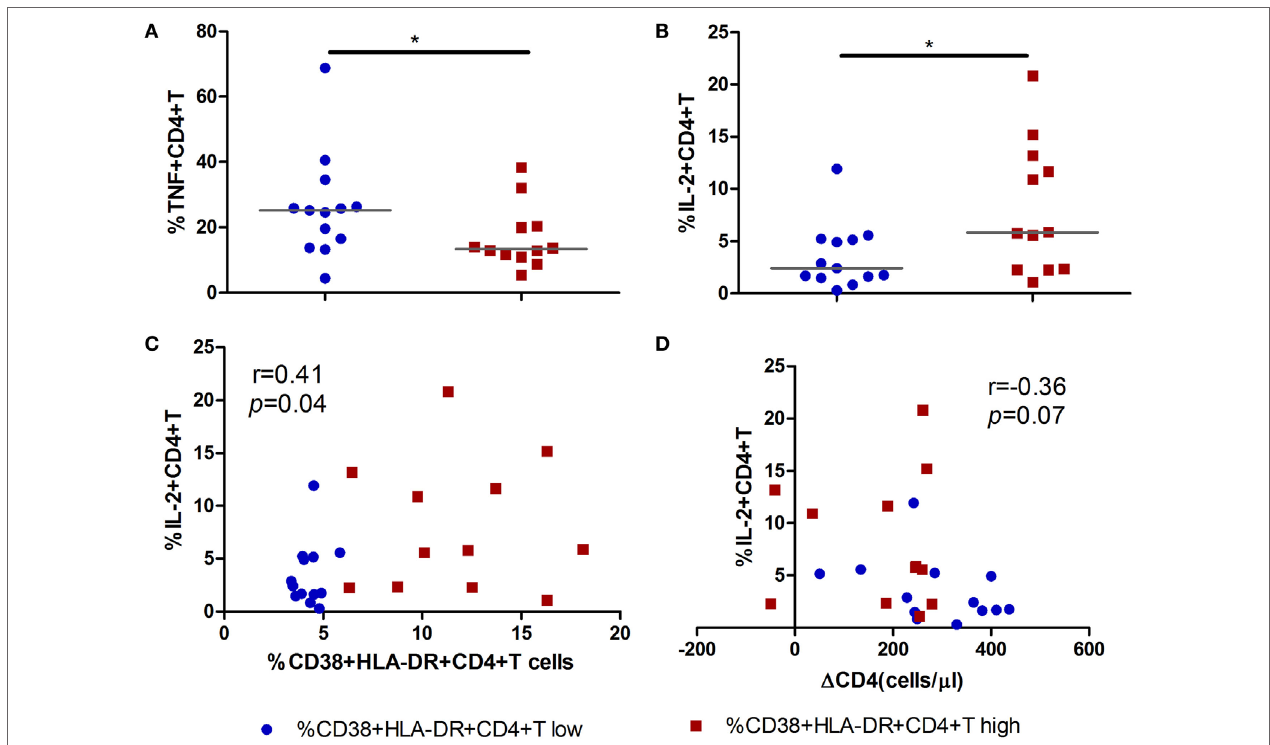
FigUre 5 | Secretion of IL-2 by CD4 + T cells in acute HIV-1 infection is associated with the maintenance of CD4 + T cells. Comparisons of TNF- α (a) and IL-2 (b) secreting capacity of CD4 + T cells between CD4 + T cell activation high ( ■ ) and low ( ● ) groups in acute HIV-1-infected patients. Correlation analysis between IL-2 and the level of CD4 + T cell activation (c) and Δ CD4 (D) . Significance of difference was calculated by Mann–Whitney U test. Correlation analysis was performed by Spearman’s rank test. Horizontal lines indicate median values (* p < 0.05, ** p < 0.01, *** p <